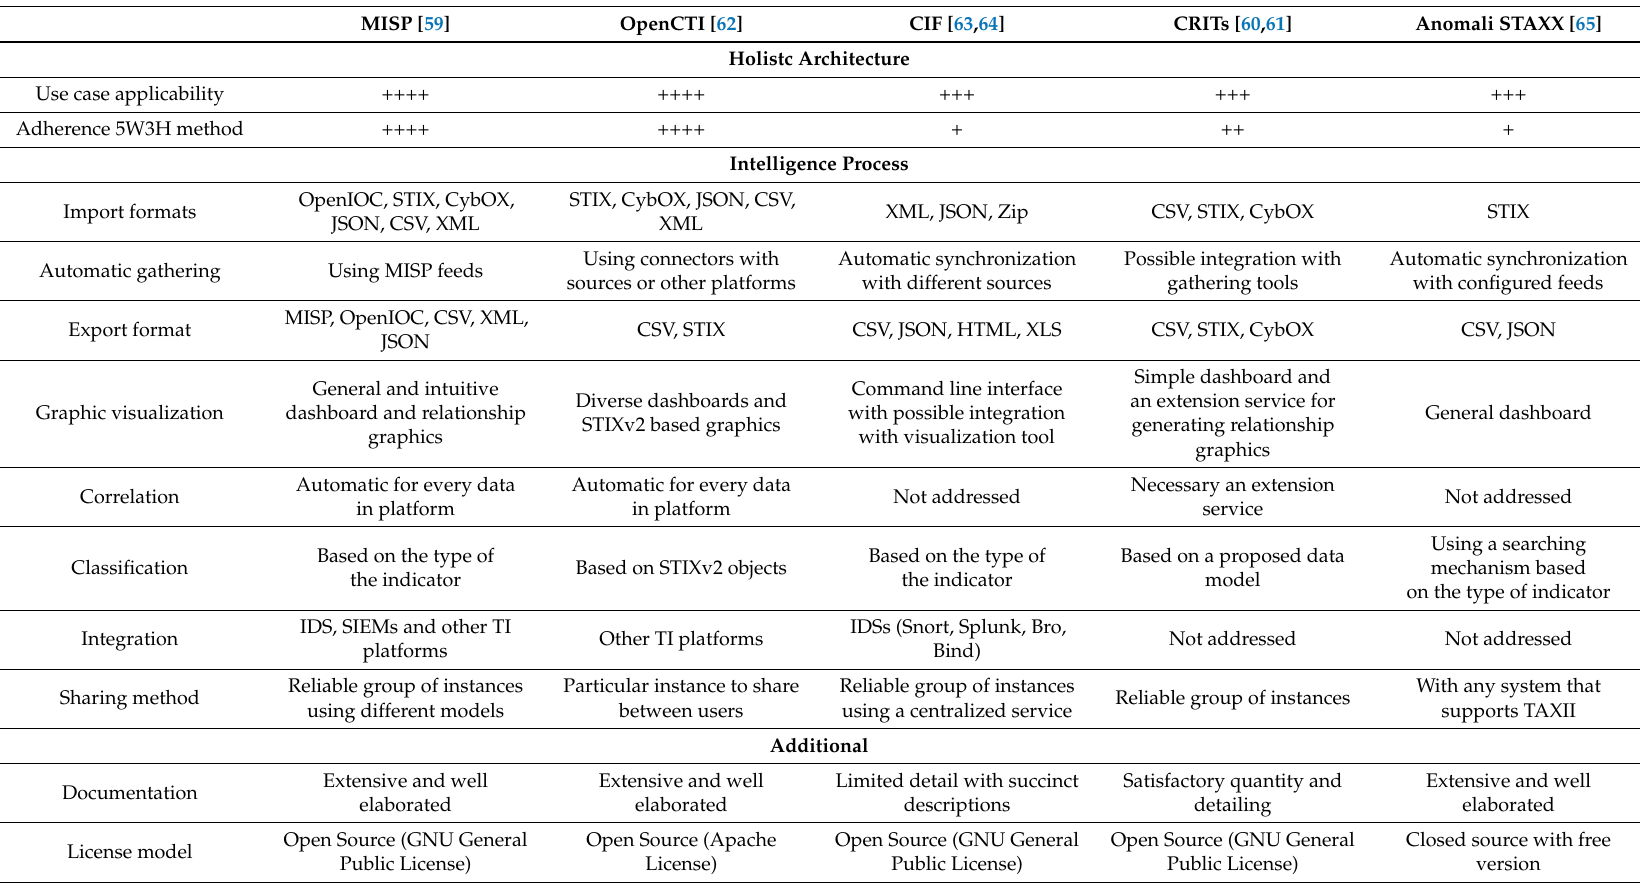
Table 7. Evaluation of TI